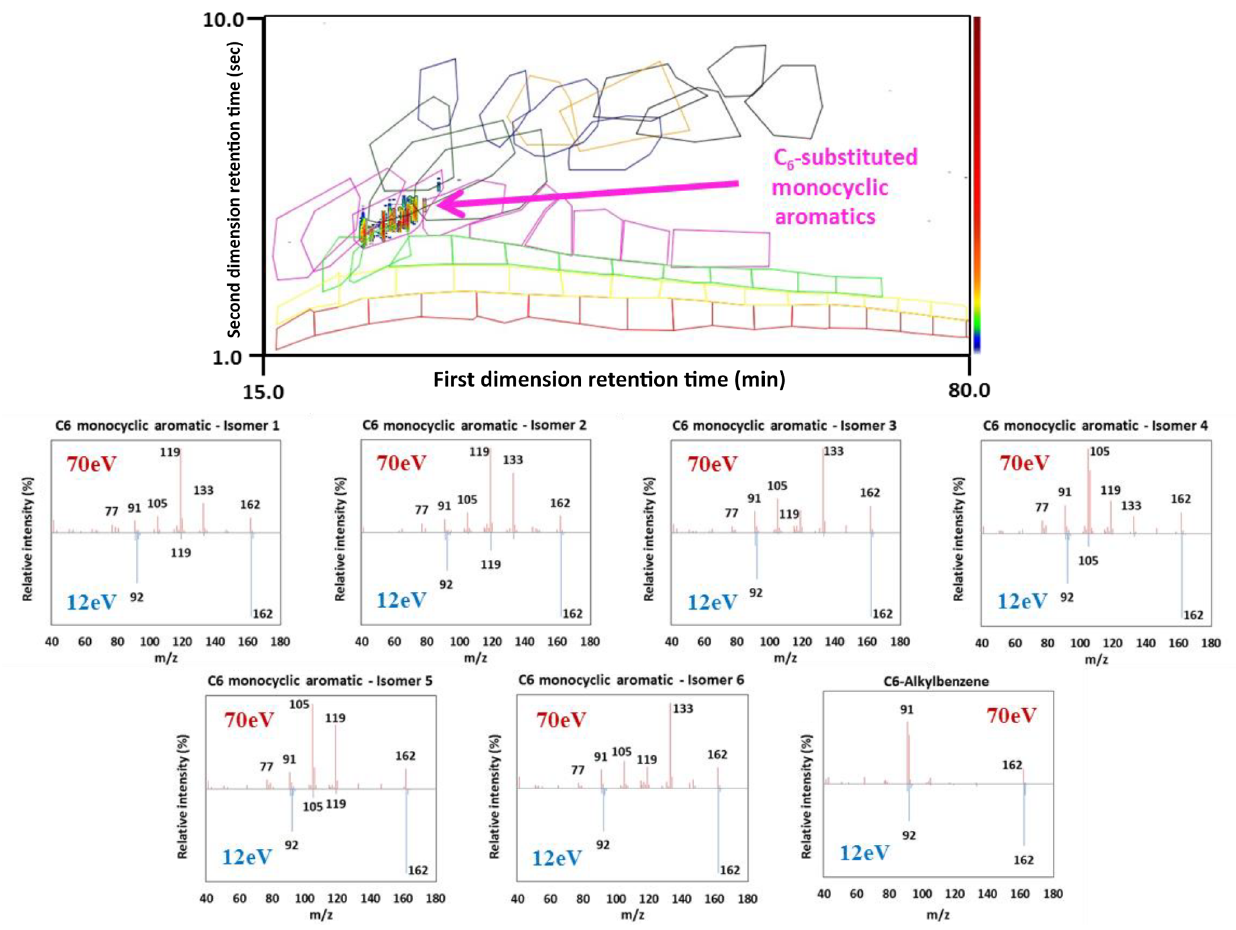
Figure 2. A contour plot (chromatogram with 12eV ionization mass spectrometry) displaying C 6 -substituted monocyclic aromatics identified by the CLIC expression. All C 6 -substituted monocyclic aromatics are located within the pink polygon displayed. 70eV (red peaks) and 12eV (blue peaks) mass spectra corresponding to the peaks identified by the CLIC expressions in the SIC is shown for six different C 6 -substituted monocyclic aromatics